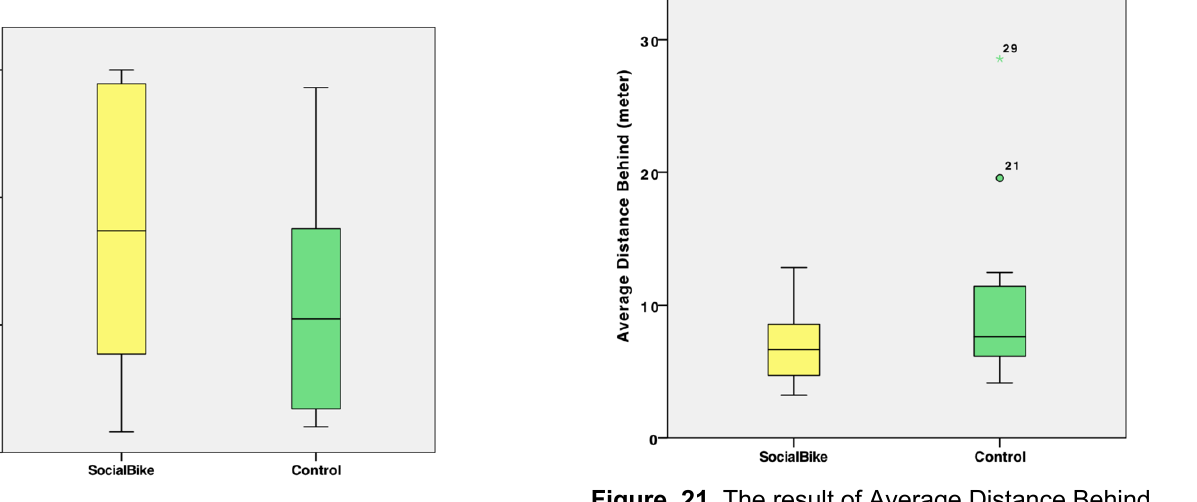
Figure. 19. The result of Total Time Behind (second)